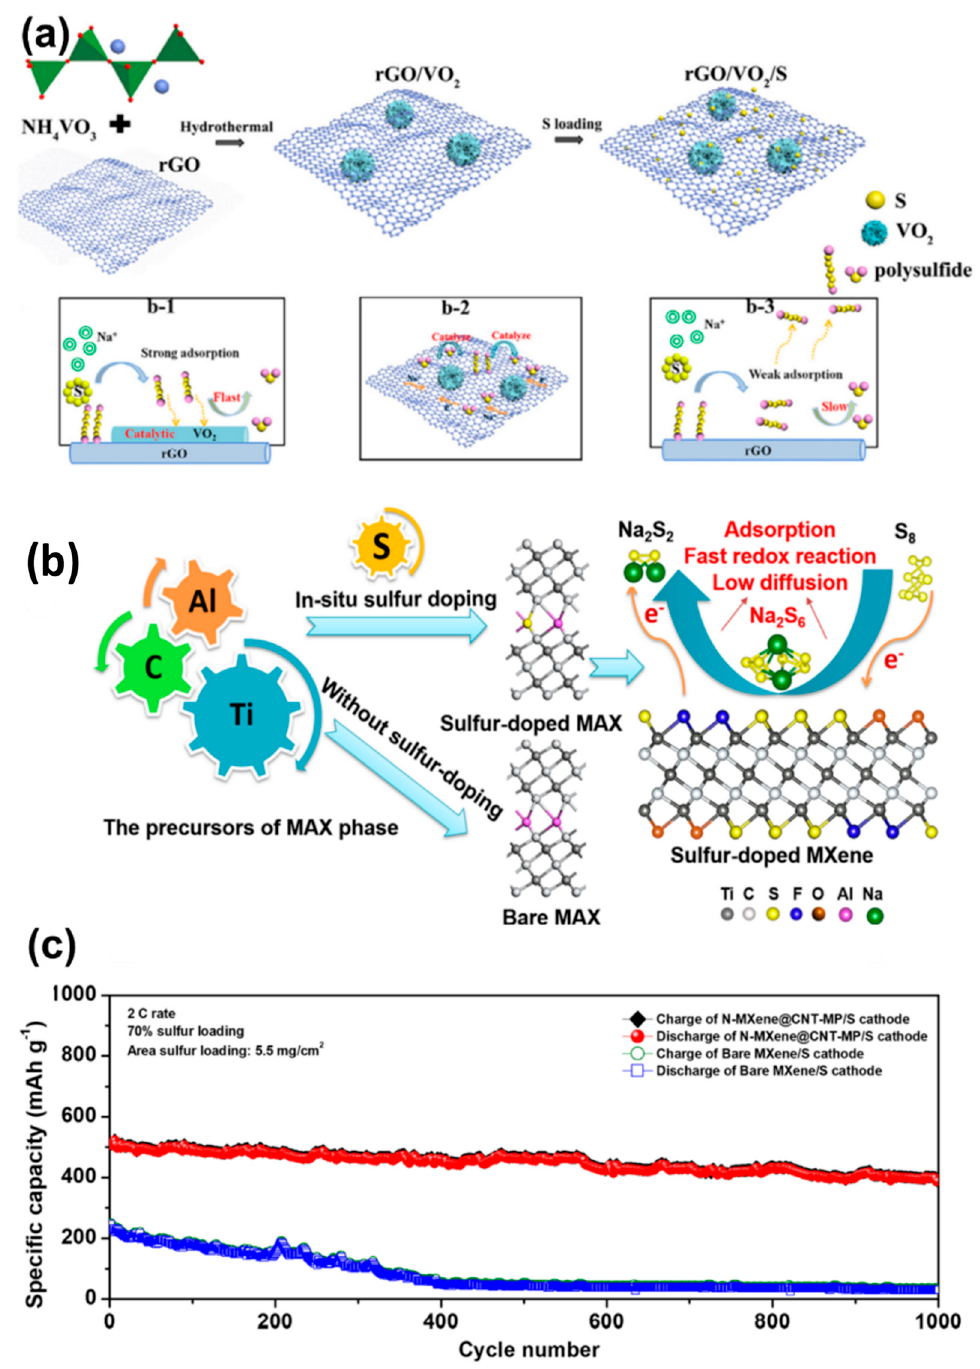
Figure 5. ( a ) VO 2 -embedded rGO. Reproduced with permission [65]. Copyright 2019, Elsevier. ( b ) Sulfur-doped MXene [67]. Copyright 2019, American Chemical Society. ( c ) Cycle performances of N-doped Ti 3 C 2 T x MXene microspheres. Reproduced with permission [68]. Copyright 2021, American Chemical Society.